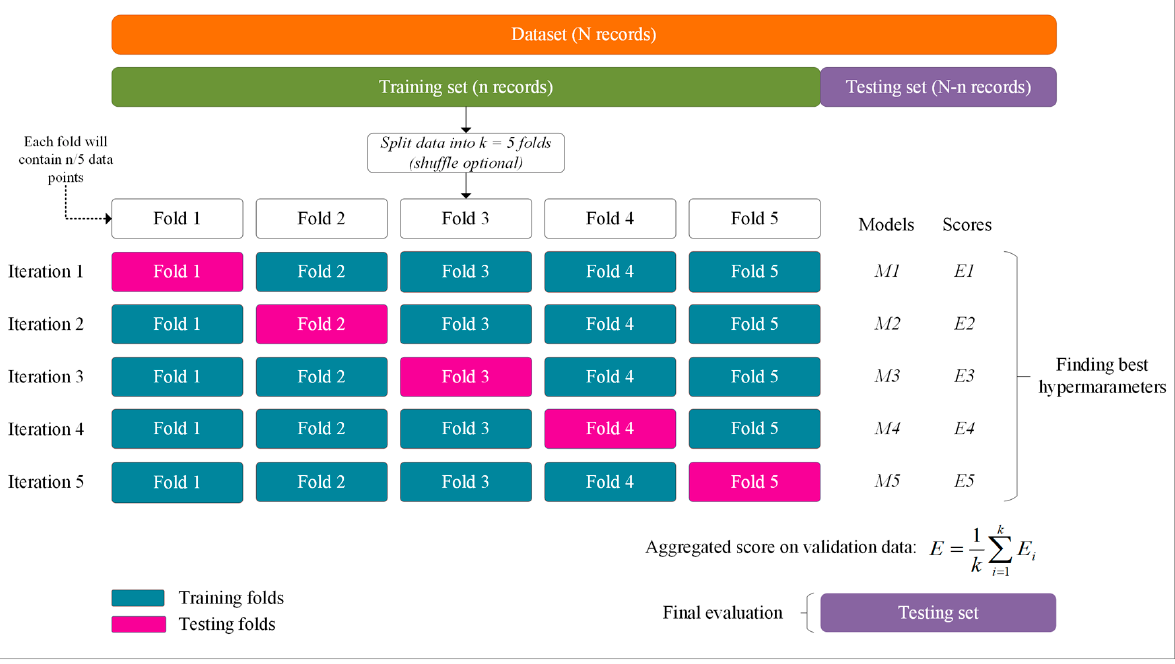
Figure 11. Use of each fold in the cross-validation process (fivefold representation).